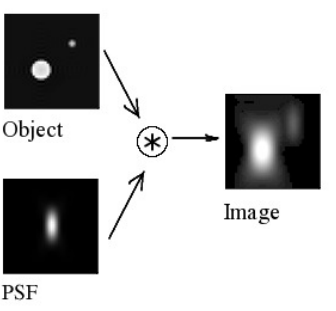
Figure 7. Object image blurred using the point spread function.